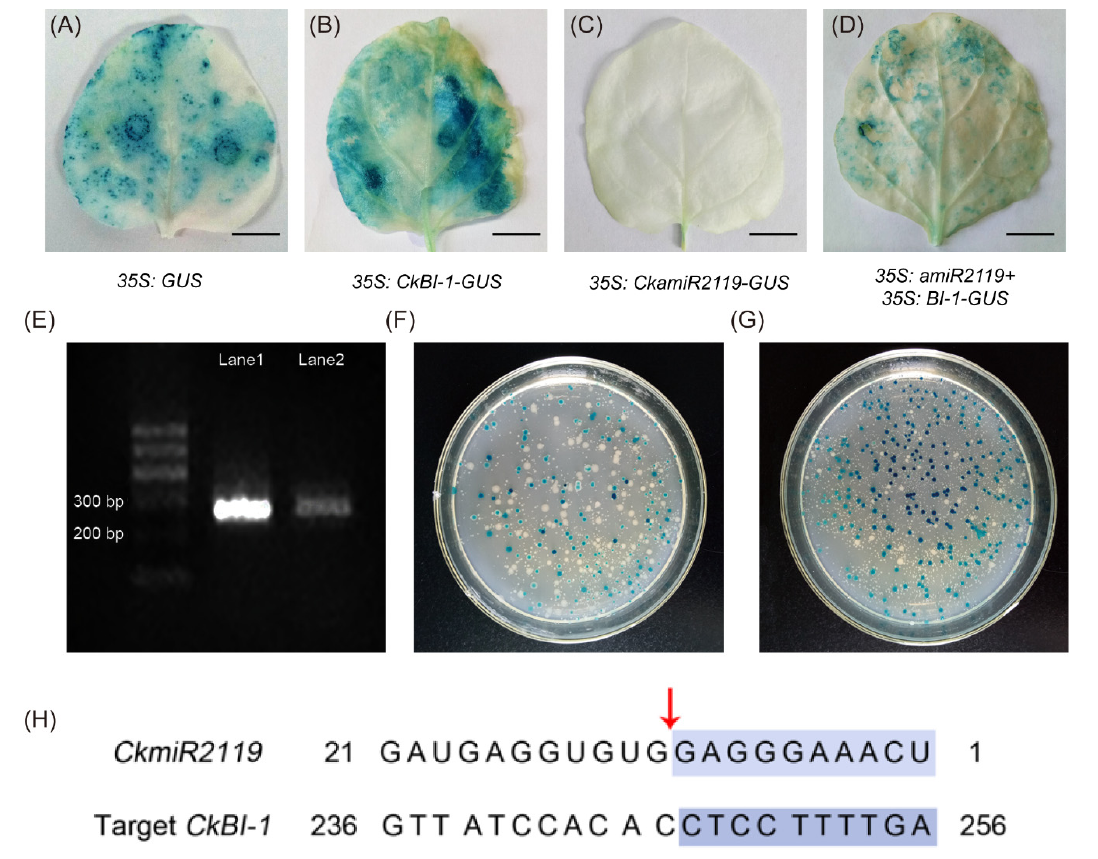
Figure 3. Validation of the targeting relationship between CkamiR2119 and CkBI-1 . ( A – D ) Verification of the targeting relationship between CkamiR2119 and CkBI-1 transient expression in tobacco leaves. ( A ) 35S: GUS . ( B ) 35S: CkBI-1-GUS . ( C ) 35S: CkamiR2119- GUS . ( D ) 35S: CkamiR2119 and 35S: CkBI-1-GUS cotransformation. ( E ) RLM-5 ′ RACE nested PCR second-round amplification results. ( F , G ) Screening of positive clones after the amplified product is connected to T vector. ( H ) The cleavage site of CkmiR2119. Scale bars in ( A – D ), 10 mm.